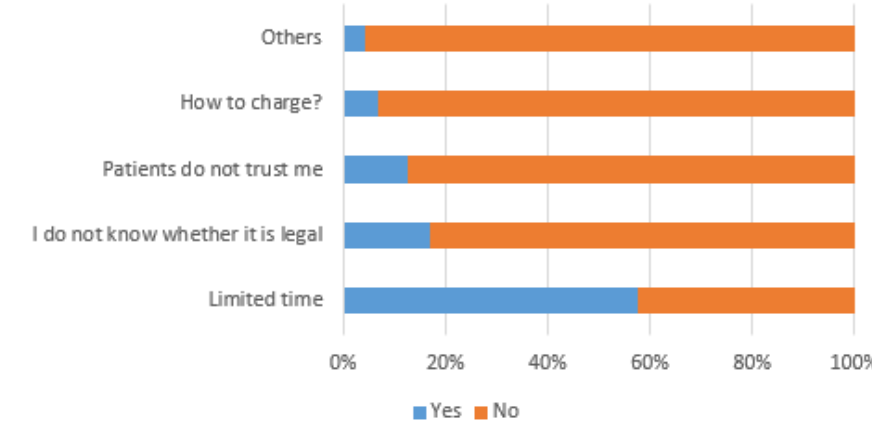
Figure 2. The biggest obstacles to experts’use of apps to manage diabetes patients (n=118).